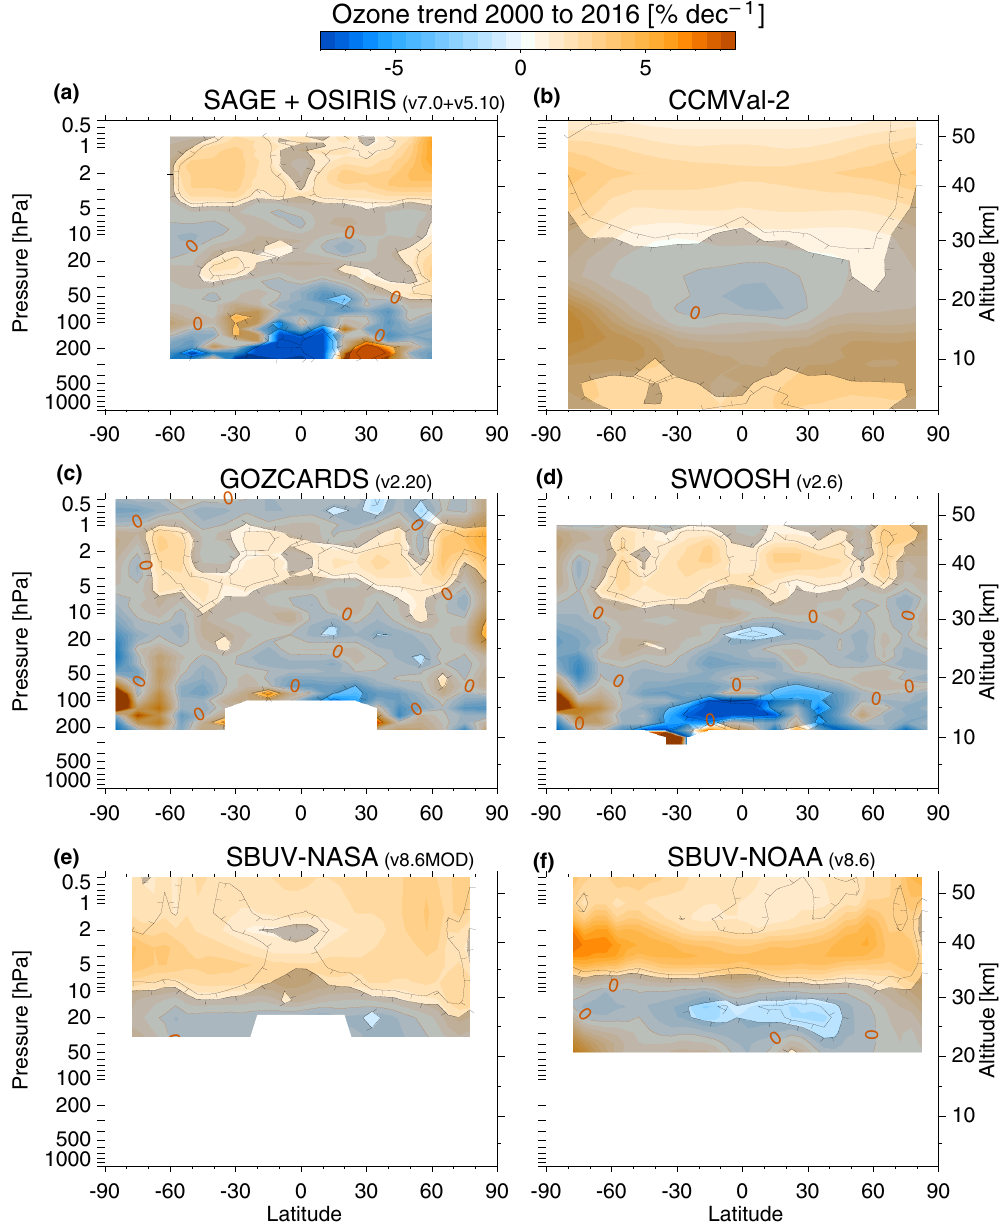
Figure 2. Latitude pressure cross section of 2000 to 2016 ozone trends TR obtained by 2-step multiple linear regression (see text). Panel (b) is for model simulations from the CCMVal-2 initiative. The other panels are for merged satellite data sets. The colour scale gives trend magnitude TR. Shading and isolines give the ratio of trend to trend uncertainty, | TR | /σ . Grey shading, in regions where | TR | ≤ 2 σ , indicates that trends are not significant at the 95% confidence level. The next isoline is at | TR | /σ =